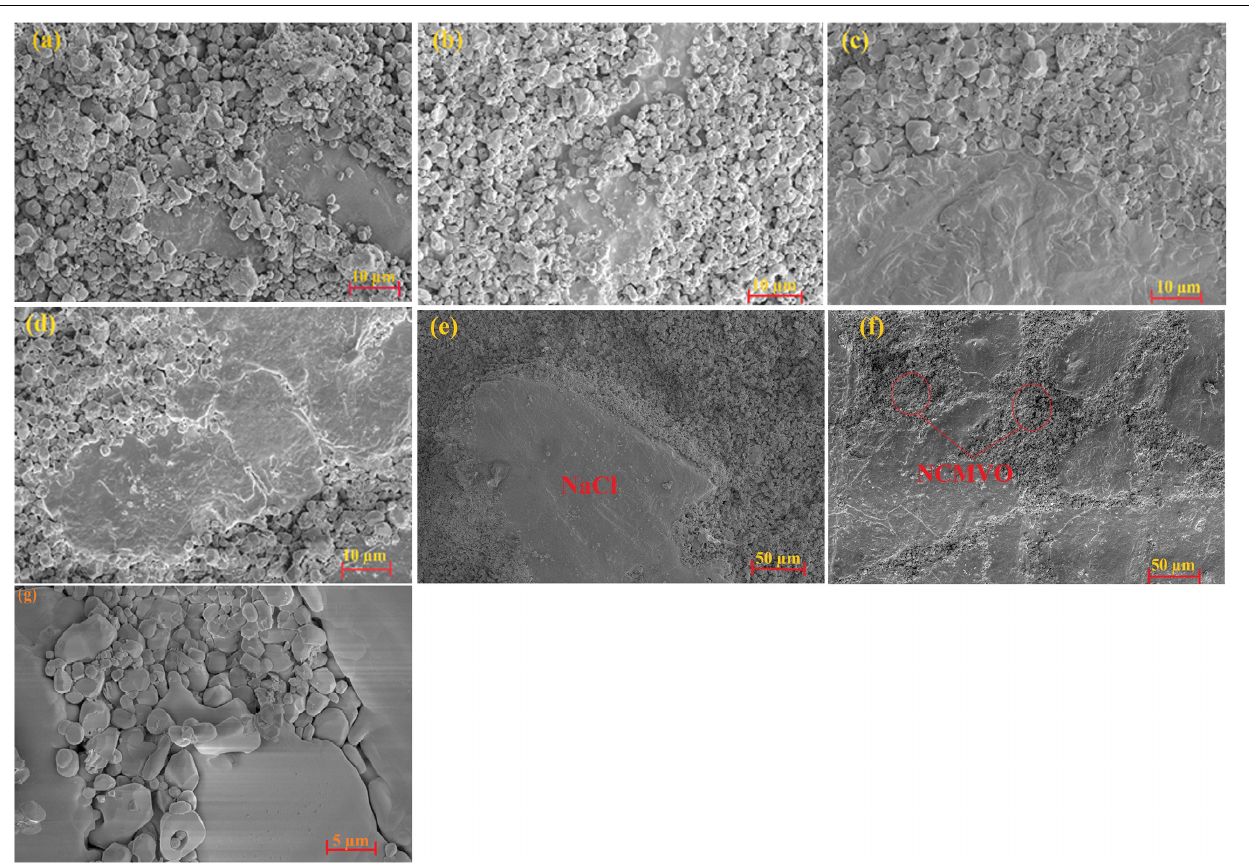
FIGURE 5 | The microstructure of (1 – x ) NCMVO-xNaCl (a,e) x = 0.4 NaCl, (b) x = 0.5, (c) x = 0.6, and (d,f) x = 0.7, and (g) fractured surface of 0.5 NaCl–0.5 NCMVO composites.